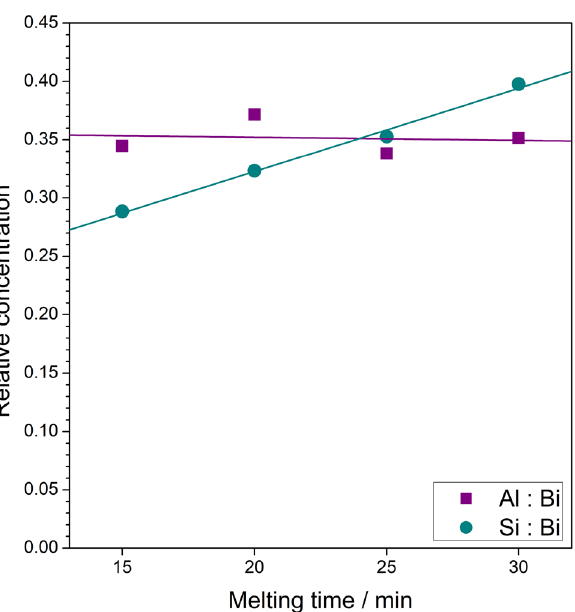
Figure 5. Relative concentrations of Si and Al dopants in the function of melting time during syntheses. Values are given as atomic Si:Bi and Al:Bi ratios and were determined from EDS analyses. Al content remains approximately constant regardless the melting time, while Si dopant linearly